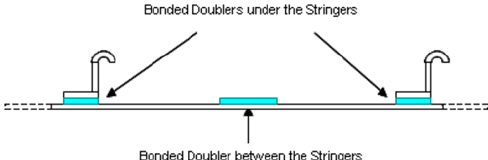
Figure 3: Representations of the possible placements of the doublers: in the middle of the bay (between the stringers) or under the stringers.